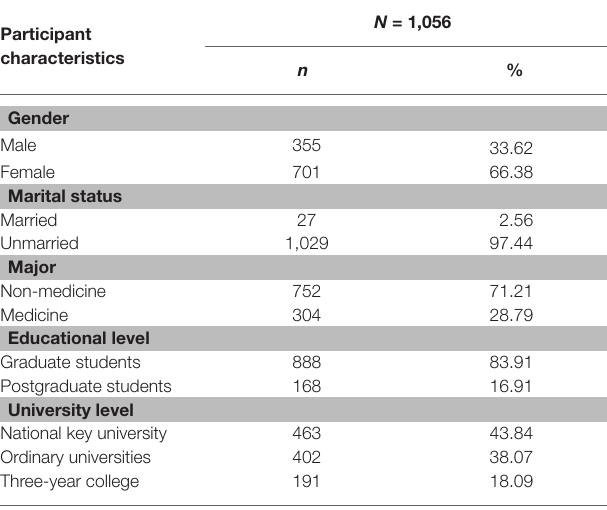
TABLE 1 | Demographic characteristics of participants. Participant